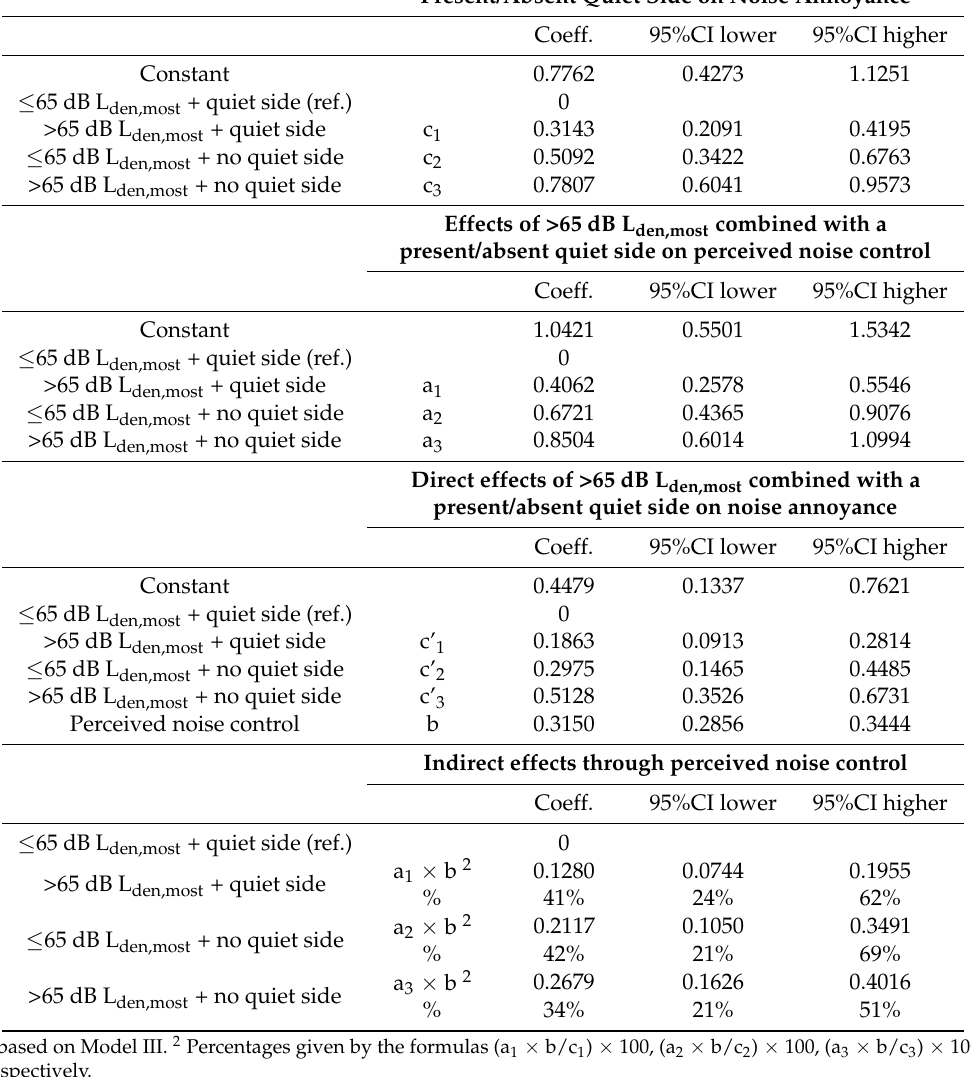
Table 9. Joint associations of exposure to road traffic noise (>65 dB L den,most ) and present/absent quiet side (intersection in front of living or sleeping room) with perceived noise control and noise annoyance 1 . Total Effects of >65 dB L den,most Combined with a N = 1812 Present/Absent Quiet Side on Noise Annoyance Coeff. 95%CI lower 95%CI higher Constant 0.7762 0.4273